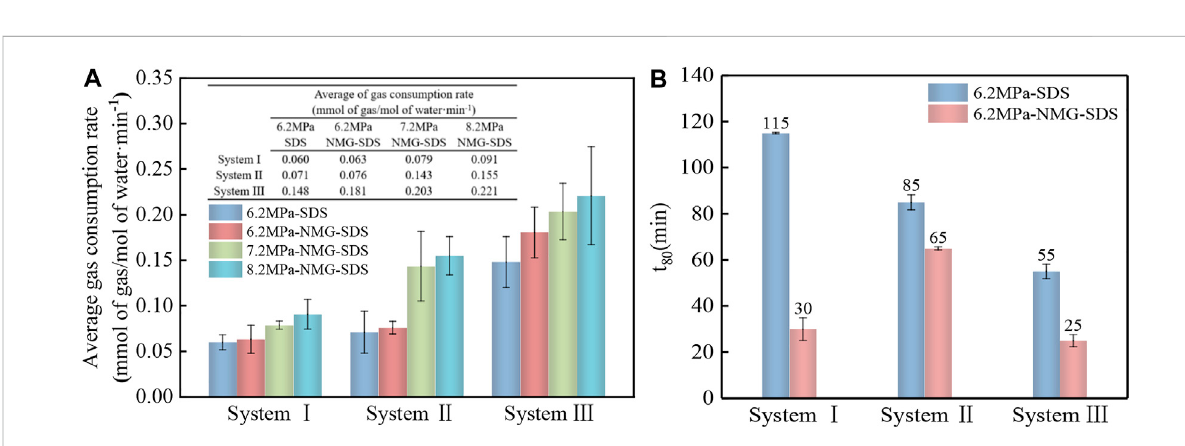
FIGURE 8 Gas consumption rate during gas hydration of different gas components under different